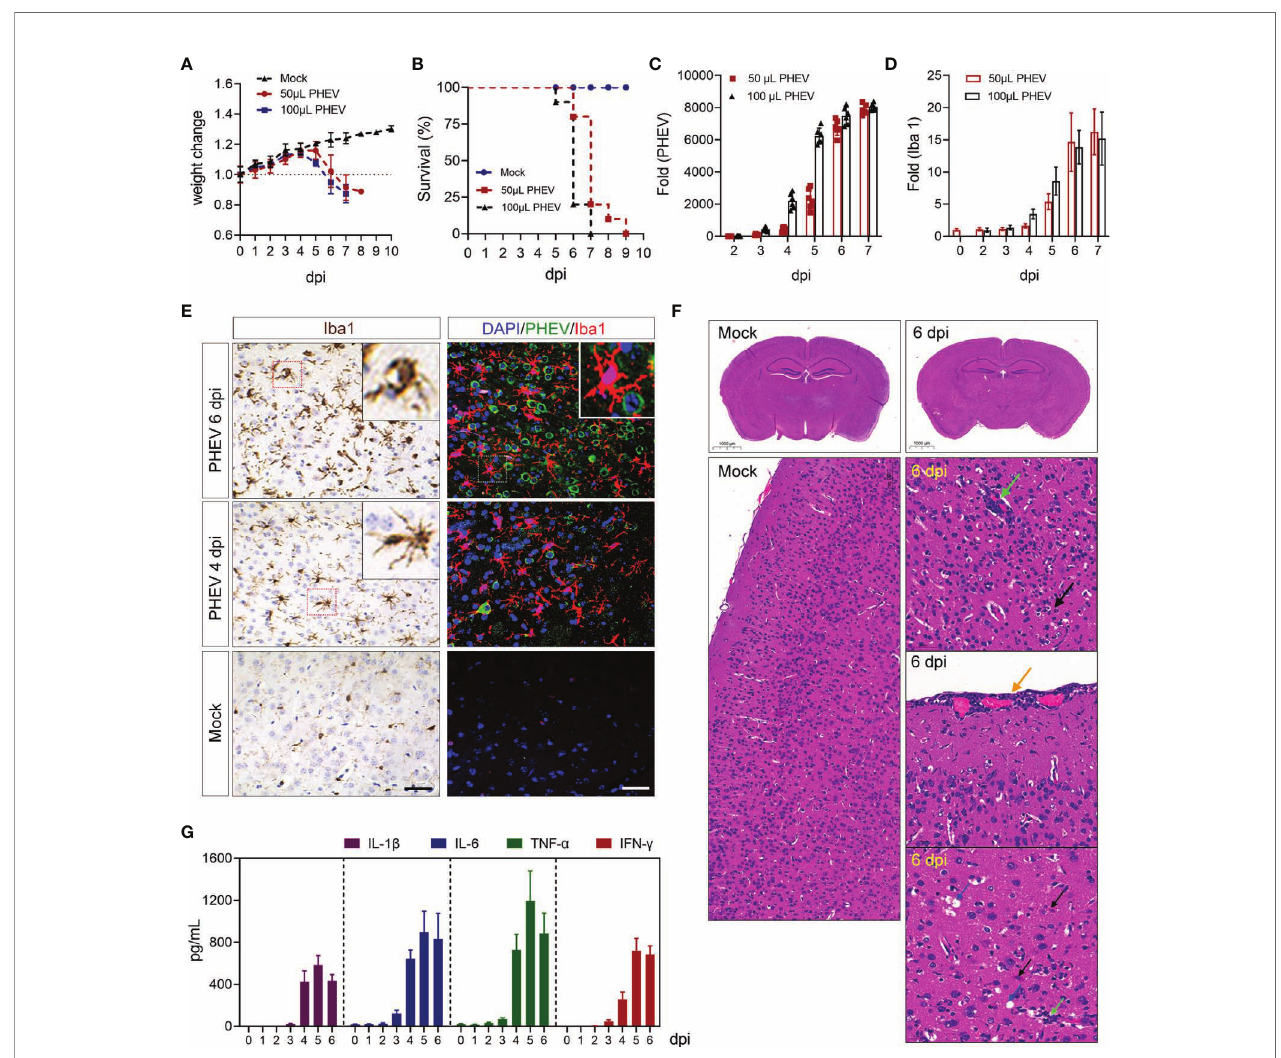
FIGURE 1 | PHEV infection induces microglial activation and neuroin fl ammation. BALB/c mice were intranasally challenged with PHEV (10 4.15 /0.1 mL TCID 50 ) at low dose and high dose, respectively. Weight changes (A) and survival (B) of PHEV-infected and control mice were recorded daily after infection. (C) Brain tissue was collected daily, and total RNA was extracted to evaluate viral RNA abundance (n=6). Fold change is relative to mRNA level at 2 dpi, when viral RNA could be detected in the cerebral cortex. (D) The expression of the Iba 1 mRNA was evaluated using qRT – PCR, with being relative to that at 0 dpi (n=6). (E) Brain biopsies from PHEV-infected mice collected at 4, 6 dpi were subjected to immunohistochemical staining for Iba 1 or immuno fl uorescence staining with Iba 1 (red) and PHEV- N (green) antibodies. Bars, 200 m m. (F) Histopathology of mouse brains was observed using H&E staining. Green arrow, in fl ammatory cell in fi ltration to form vascular cuf fi ng. Yellow arrow, meningitis. Black arrow, injured neurons. Blue arrow, edema or cavity in the parenchyma and around blood vessels. (G) Secretion of cytokines was tested by ELISA